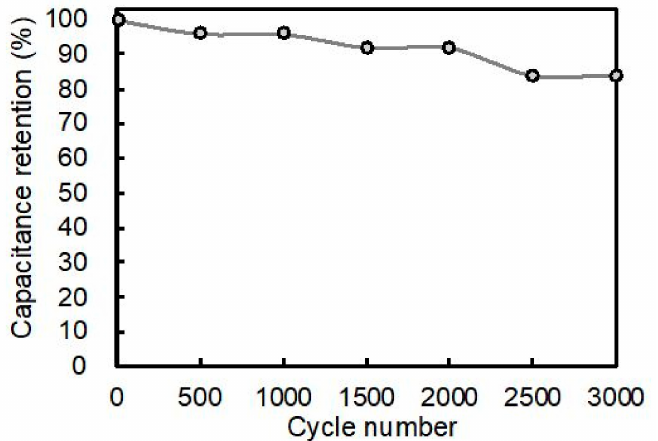
Figure 14. Cycling performance of device at charging and discharging current of 1